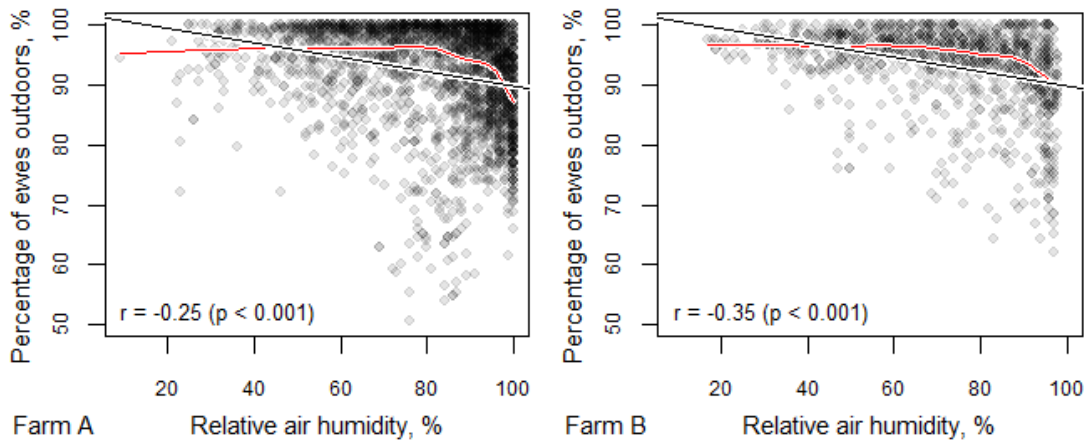
Figure 4. Percentage of ewes outdoors dependent on relative air humidity. One point corresponds to one photograph, black lines denote the linear relationship (corresponding correlation coe ffi cients with p -values are presented in the lower left corners of the figures) and the red lines indicate the potential non-linear relationship fitted with a locally weighted scatterplot smoothing (LOWESS) curve.